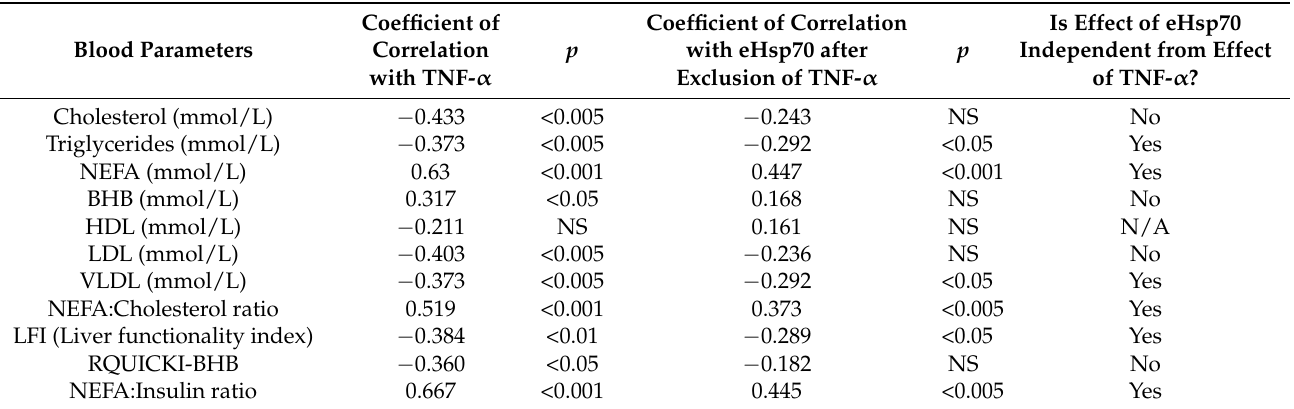
Table 2. Coefficient of correlation between lipid blood parameters and indexes with TNF- α , and partial correlation with eHsp70 after exclusion of TNF- α as control factor.